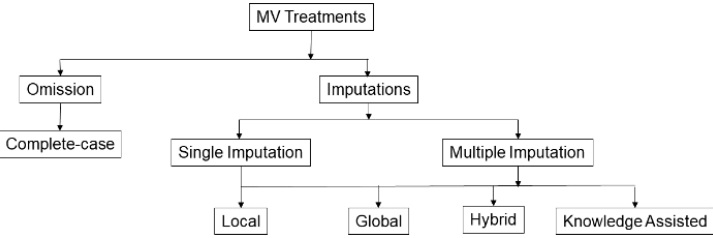
Fig. 1. Treatment of missing